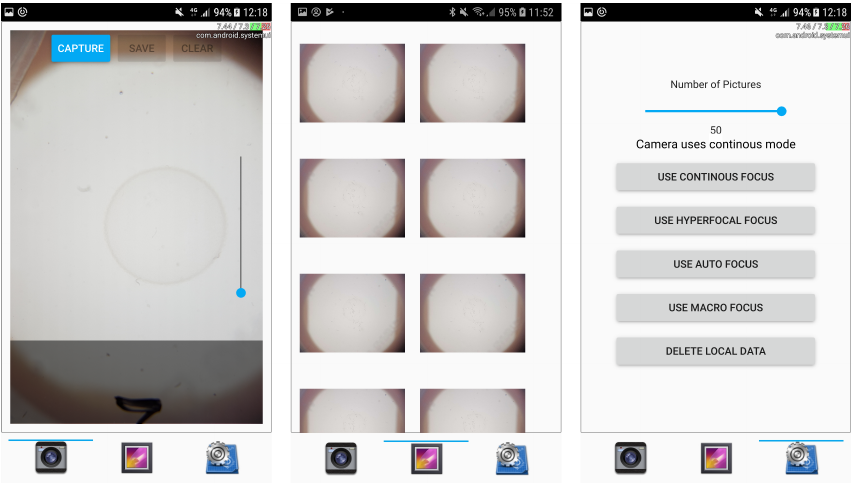
Figure 5. Smartphone application’s UI Components: image-capture dialog, gallery dialog, and settings dialog.